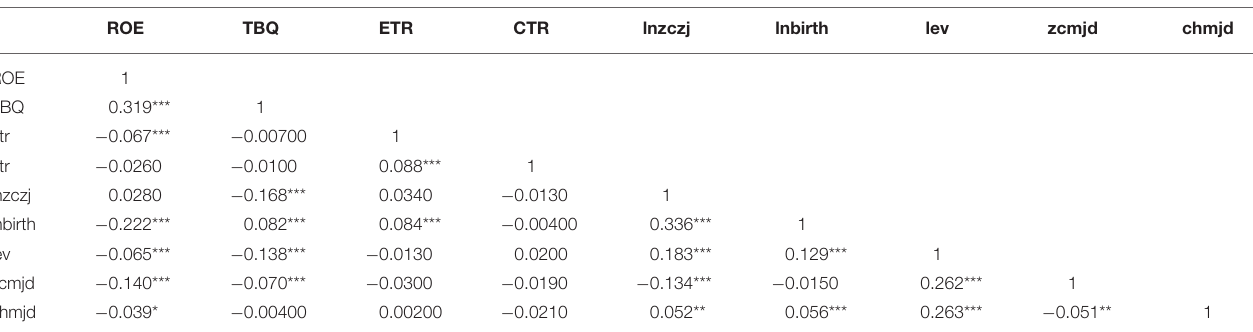
TABLE 4 | Correlation of